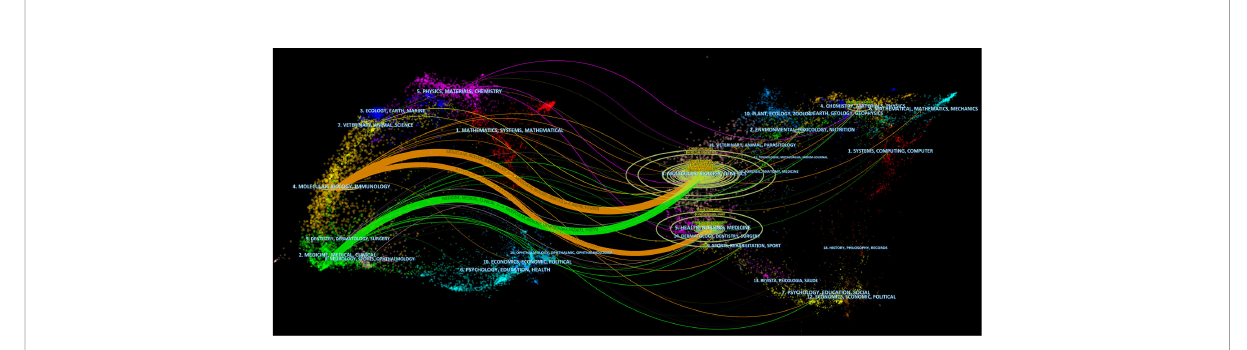
FIGURE 4 The dual-map overlay of journals. Source: authors with CiteSpace. The left side is the citing journal and the right side is the cited journal. The colored path indicates the cited relationship.